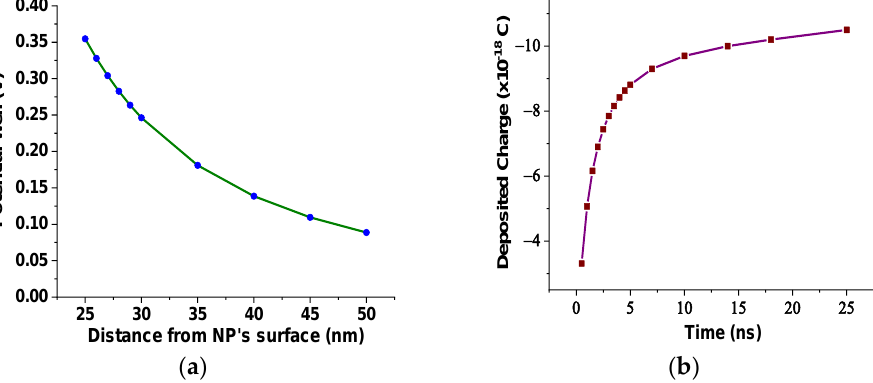
Figure 12. ( a ) Potential well distribution versus the distance from the SiC NP surface for E 0 = 20 kV∙mm −1 ; ( b ) deposited charge in each SiC NP versus time for E 0 = 20 kV∙mm −1 .